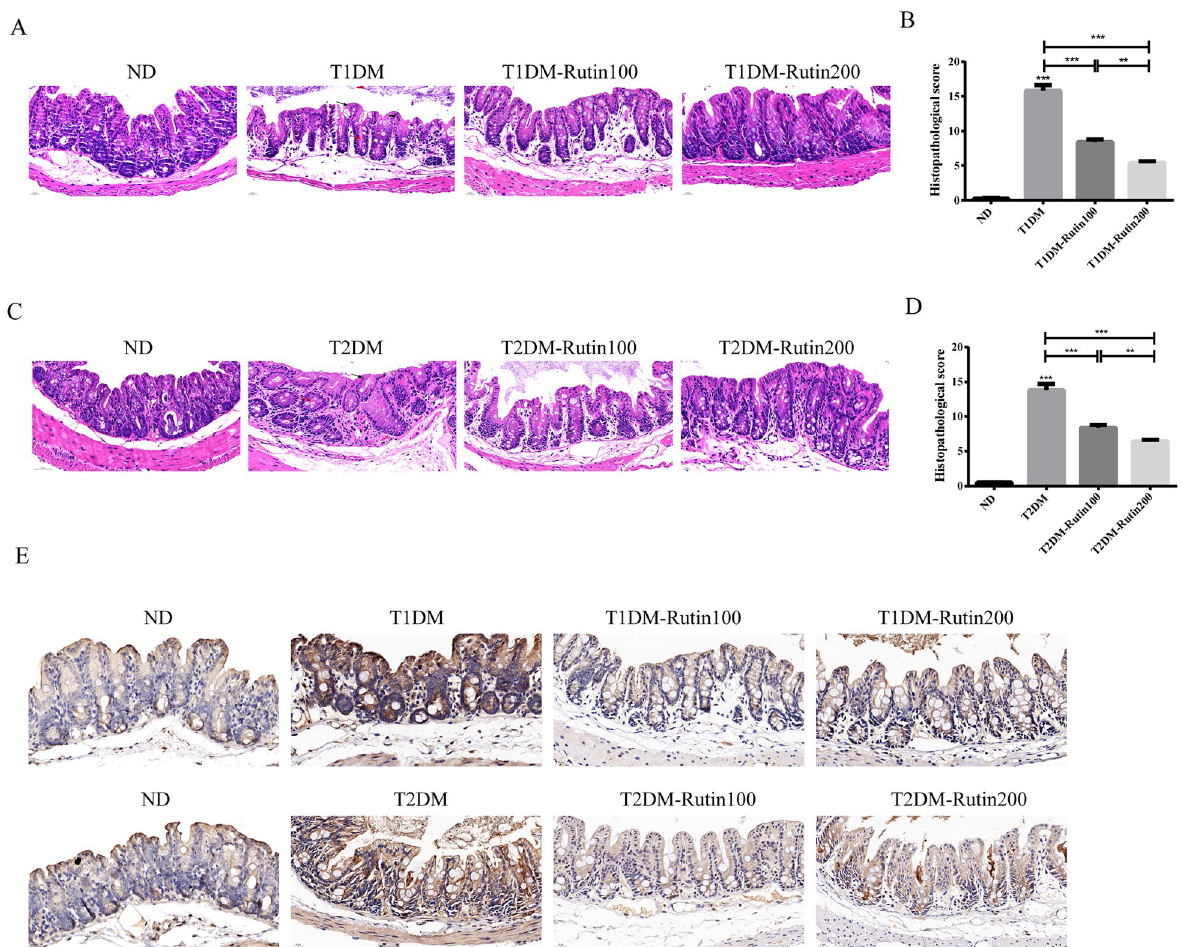
Figure 3. Rutin improved colon lesions in diabetic mice. ( A ) H&E staining of colon tissues in ND, T1DM, T1DM-Rutin100 and T1DM-Rutin200 mouse groups (scale bar: 20 μm). Red arrows: crypts; black